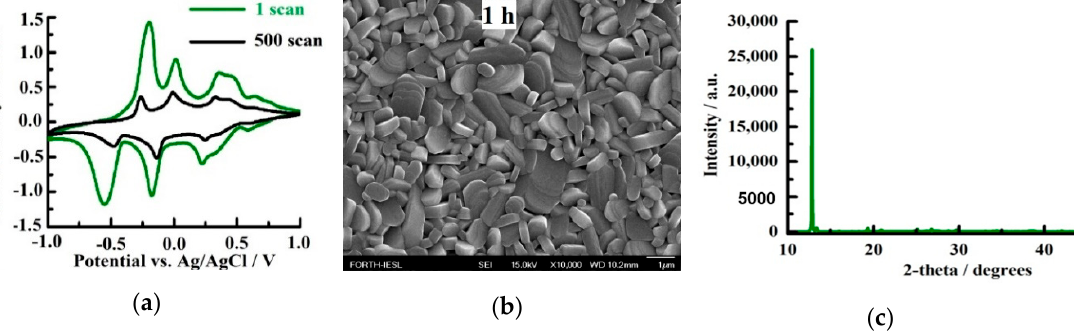
Figure 4. ( a ) Current-potential curves of the V 2 O 5 grown by AACVD at 400 ◦ C for a growth period of 1 h and annealed at 600 ◦ C for 3 h and ( b ) the FE-SEM images of the sample; ( c ) XRD pattern of the sample.